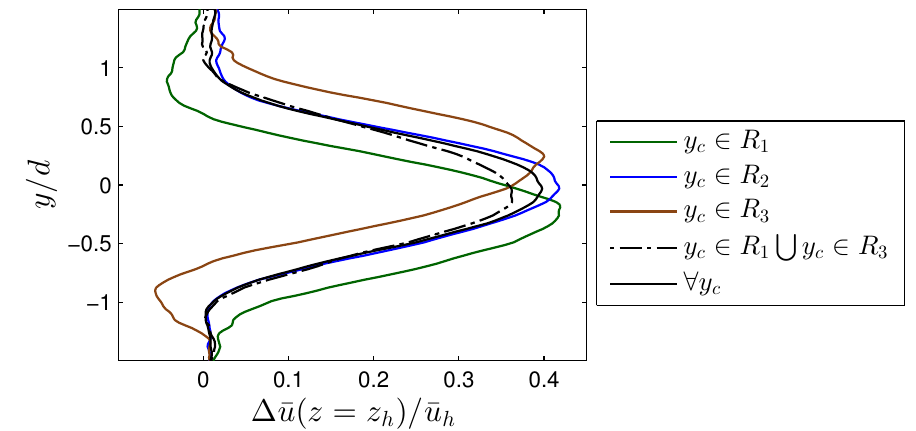
Figure 18. Lateral profiles of the normalized velocity deficit at hub height conditionally averaged based on different positions of y c at x / d =